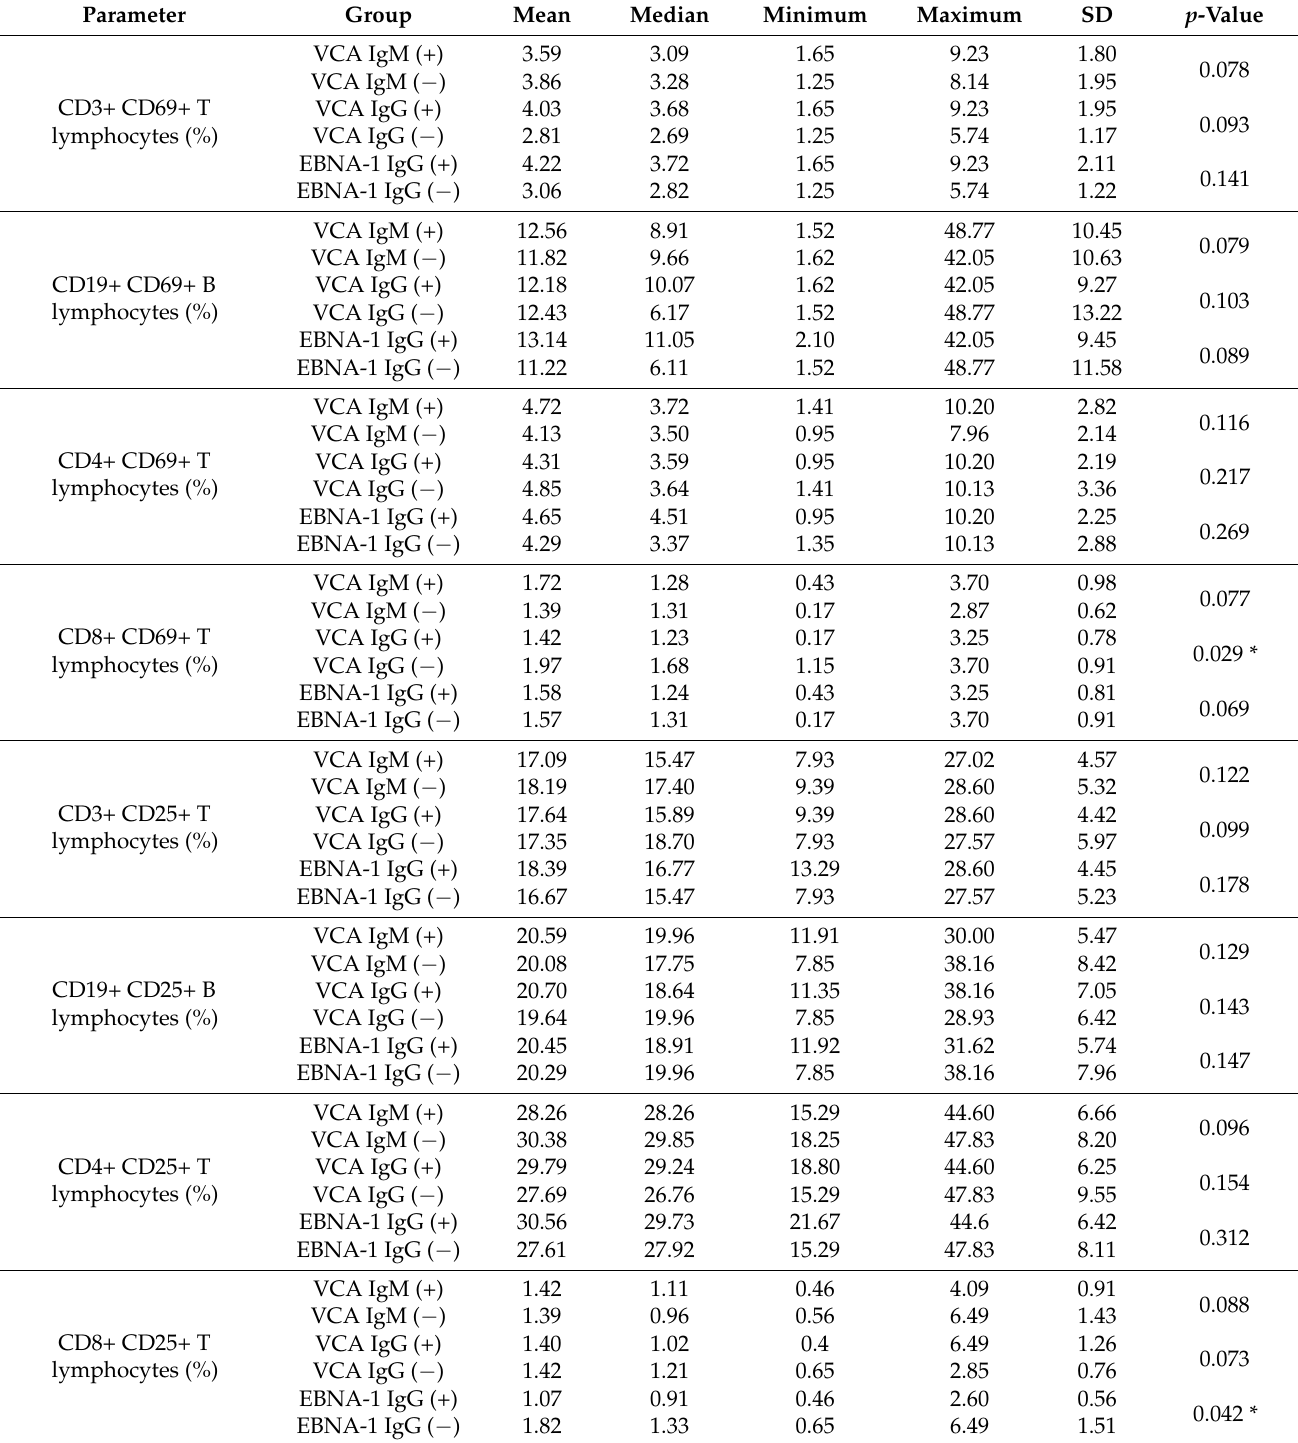
Table 6. Comparison of the percentage of lymphocytes with the expression of the CD69+ antigen in patients with type 1 diabetes in relation to the presence of anti-VCA antibodies in the IgM and IgG class and anti-EBNA-1 in the IgG